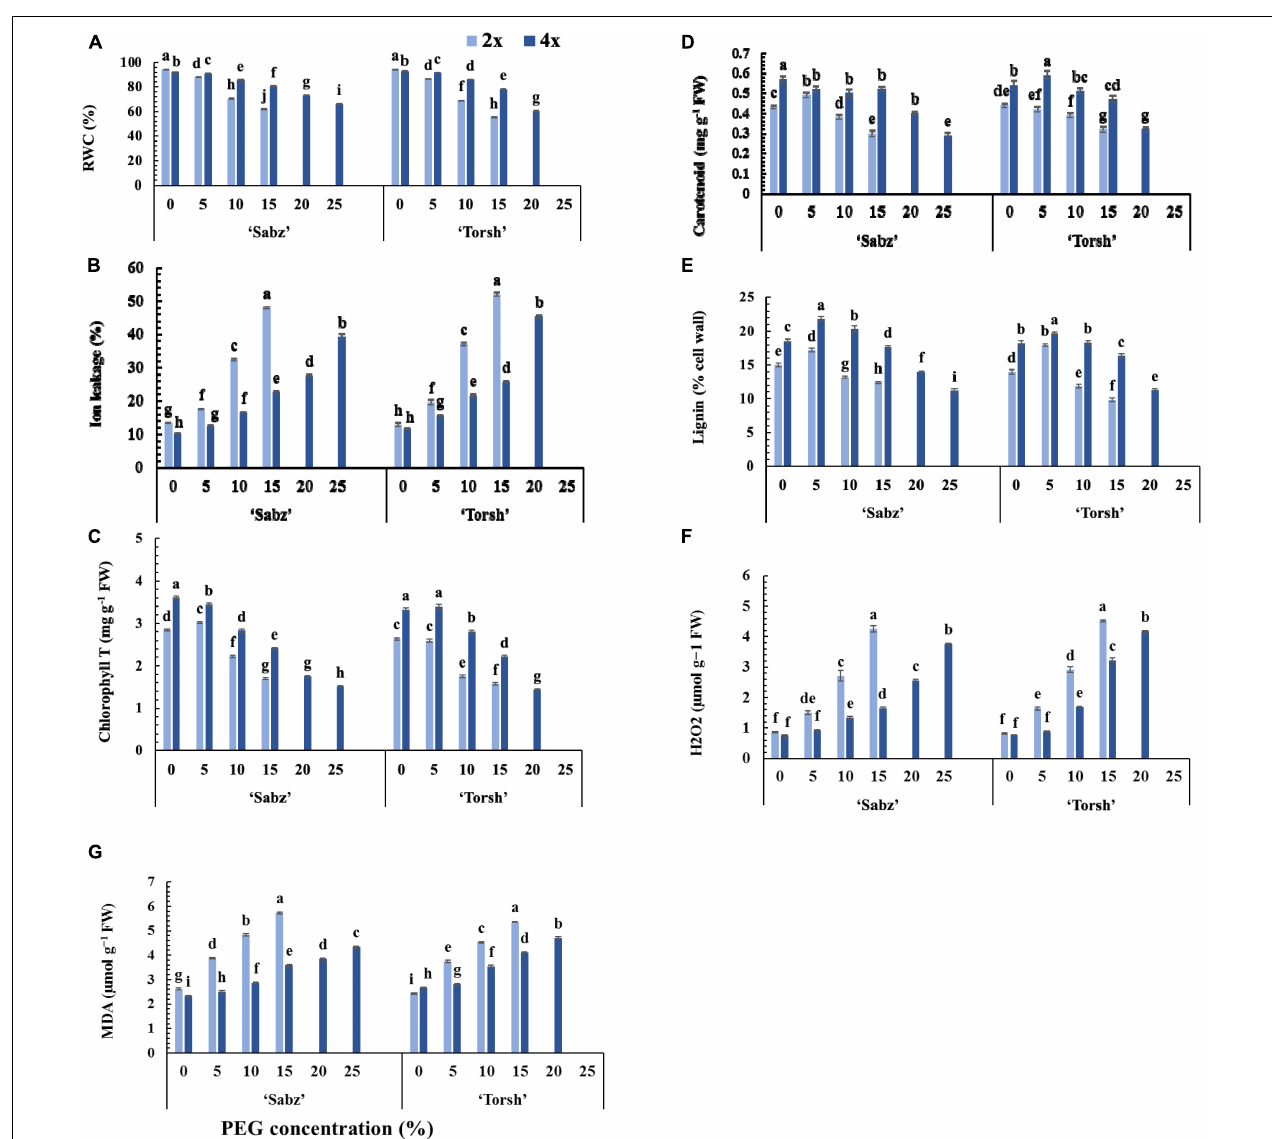
FIGURE 4 | Physiological responses of diploid and tetraploid explants of ‘Sabz’ and ‘Torsh’ fig cultivars, 14 days after subjecting to different water stress treatments. (A) Relative water content, (B) ion leakage, (C) total chlorophyll content, (D) total carotenoid content, (E) lignin, (F) hydrogen peroxide, and (G) malondialdehyde. Means represent the ploidy level and PEG treatment effects tested by two-way ANOVA. Each value represents the means ± SE. Different letters indicate significant differences at P < 0.05 using the LSD test.